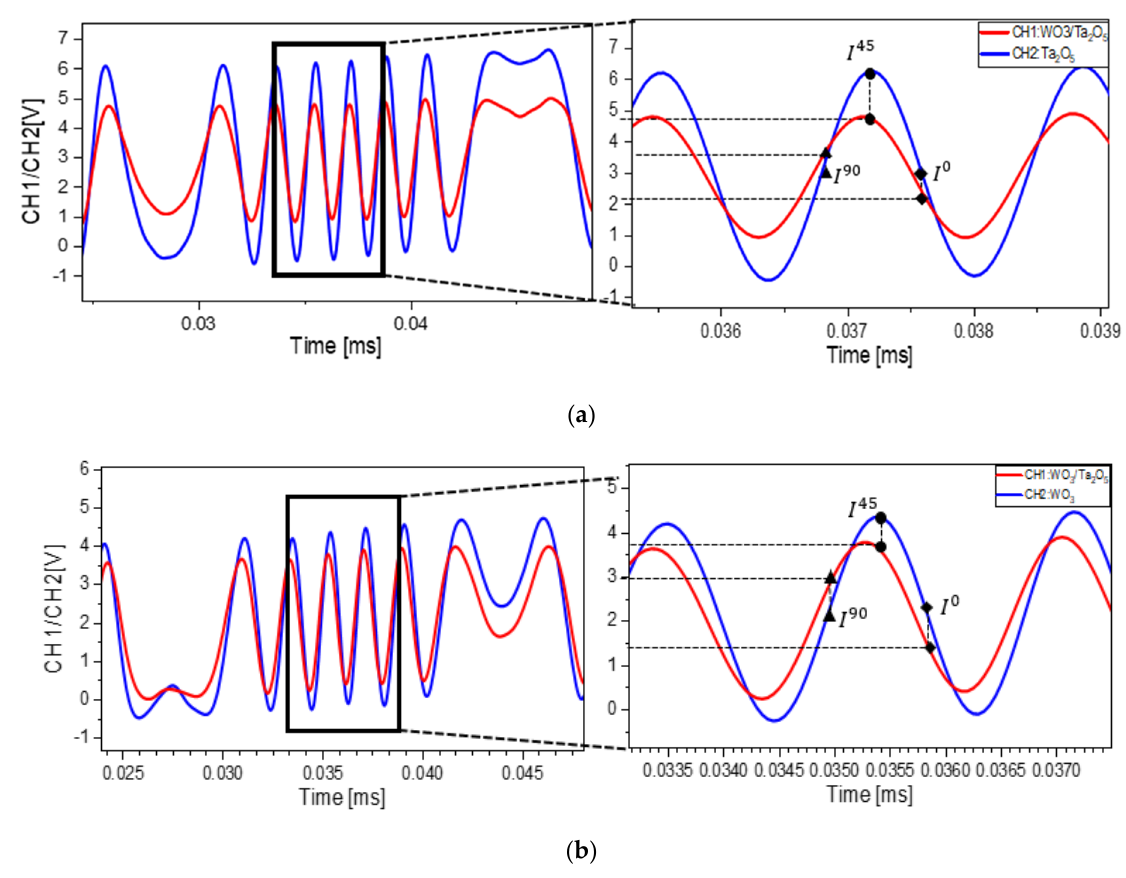
Table 2. Output intensities with BK-7 and double-layers thin-films placed in the proposed system.